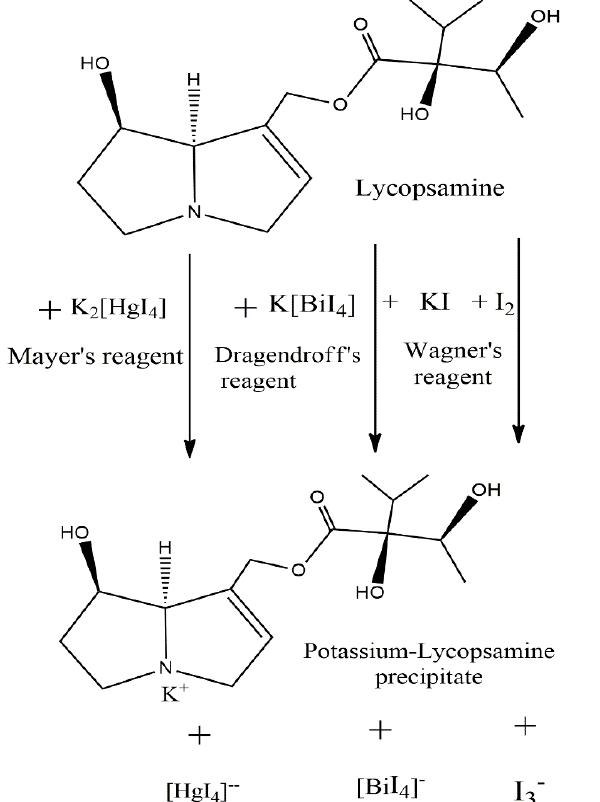
Figure 3. Lycopsamine as reference alkaloid participating in the different qualitative chemical reactions.